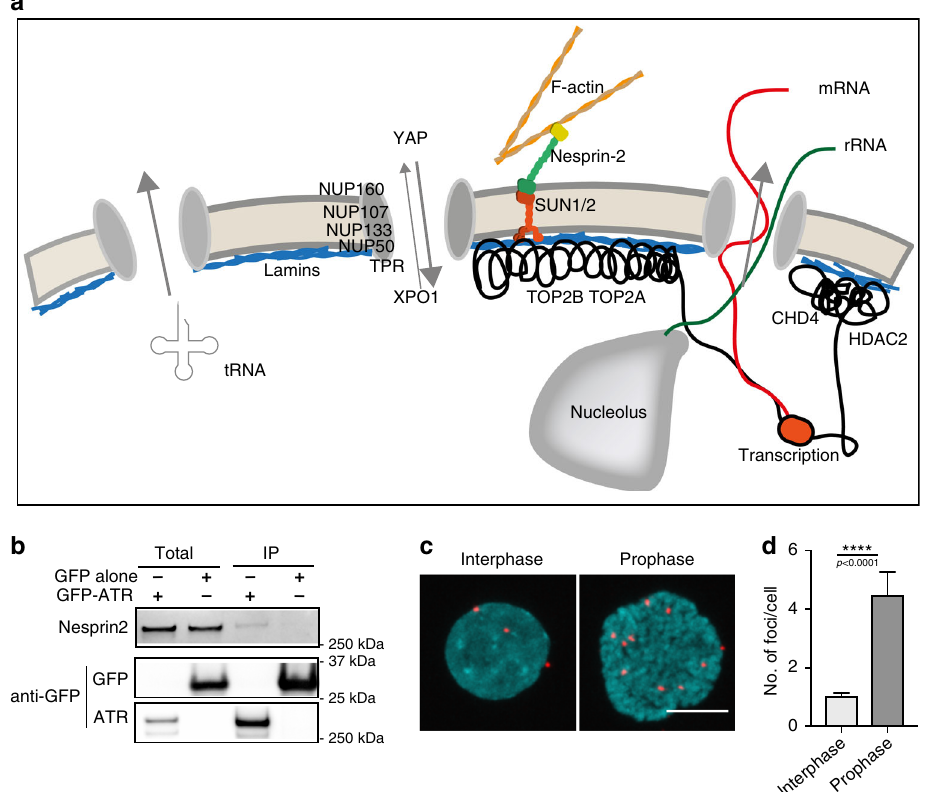
Fig. 6 ATR interactors. a Schematic summary of ATR interactors and their relative roles at the nuclear envelope and perinuclear areas b Validation of Nesprin-2 and ATR interaction using GFP-ATR immunoprecipitation and western blot analysis (full blots of Nesprin-2 with molecular weights included in Supplementary Fig. 4h and in Source data fi le). c Example of ATR – Nesprin-2 interaction foci generated by proximity ligation assay (PLA) in interphase and prophase cells (scale bar = 10 μ m). d Quanti fi cation of total number of foci present in interphase and prophase cells ( n = 65 for interphase and 10 for mitosis, pooled from 2 independent experiments). Graph presented as mean ± SEM. p -value calculated using two-tailed Student ’ s t fi ndings showing that (i) ATR is a giant HEAT repeat protein,